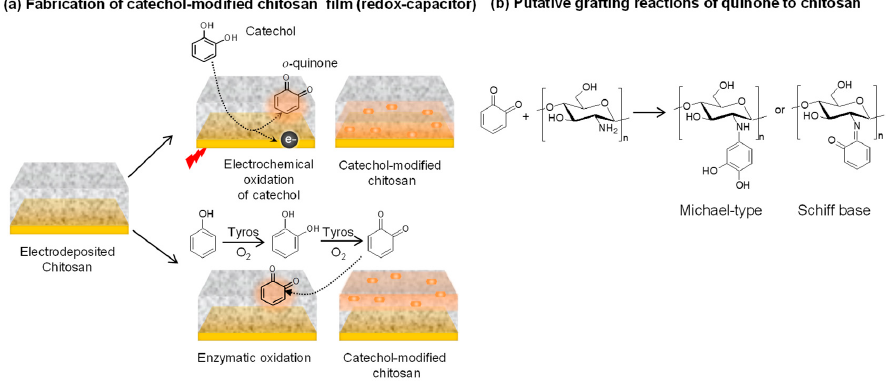
Figure 2. Fabrication of catechol-based redox-capacitor films. ( a ) Catechol is electrochemically oxidized or enzymatically oxidized by tyrosinase (Tyros) and the diffusible oxidation product ( o -quinone) grafts to the nucleophilic amines of the aminopolysachharide chitosan. ( b ) Quinone grafting likely involves Michael-type and Schiff base adduct